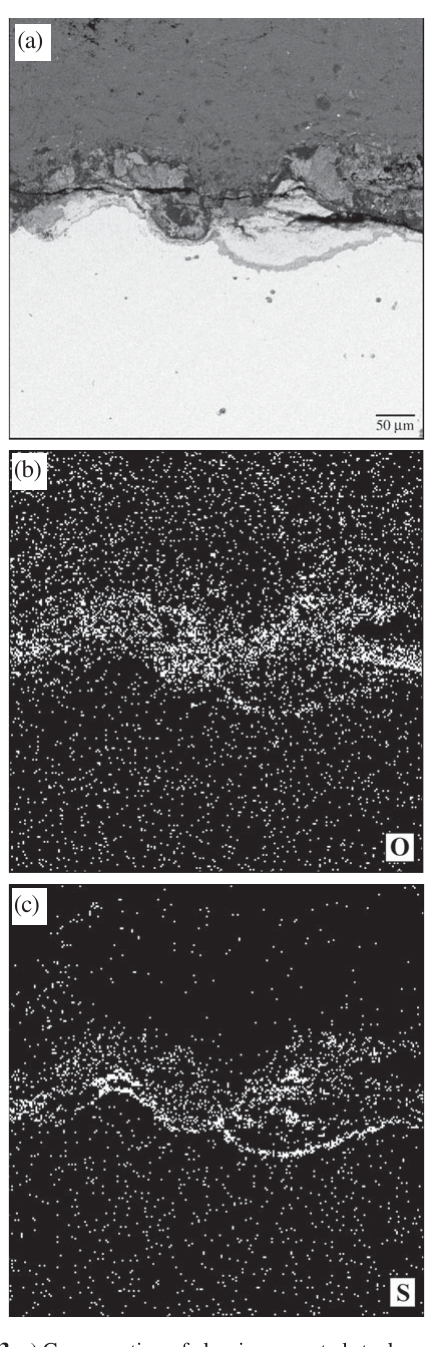
Figure 3. a) Cross-section of aluminum coated steel corroded in a vertical furnace, under simulated conditions, for 200h; b) and c) EDSmapping of oxygen and sulfur,